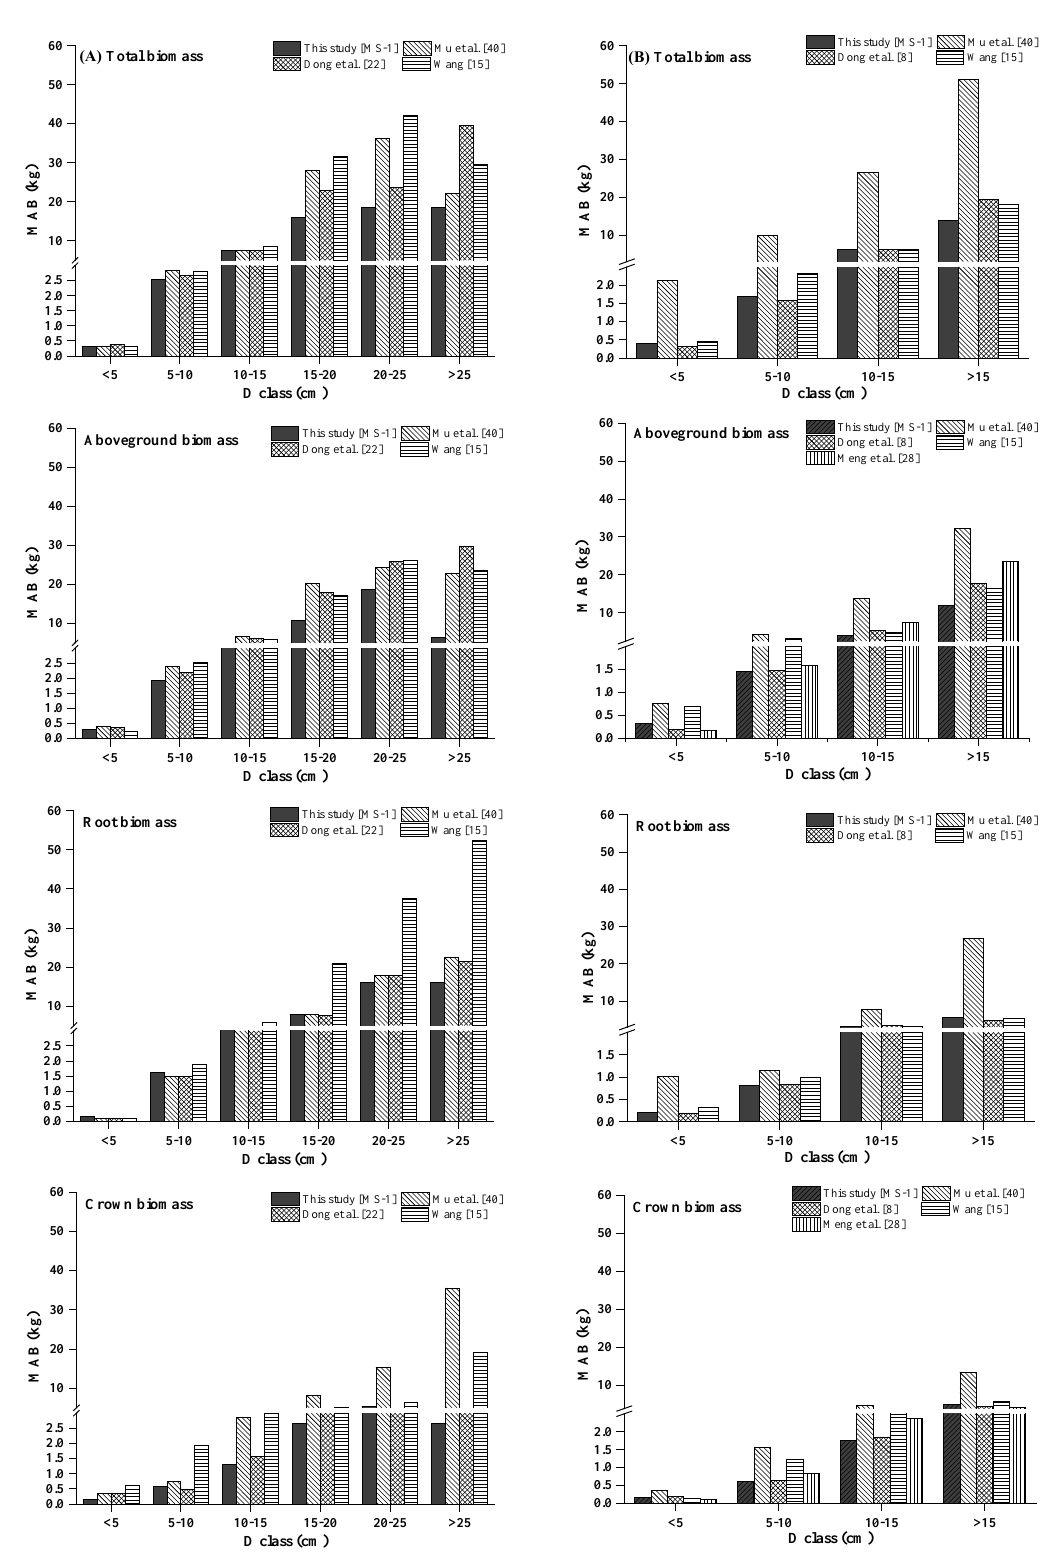
Figure 7. Mean absolute bias (MAB) computed from our MS-1 and the previously published biomass models for total, subtotal, and component biomass across 5-cm diameter classes for ( A ) Dahurian larch and ( B ) white birch. The previously published biomass models include Wang [15], Mu et al. [40], Dong et al. [8,22], and Meng et al. [28].